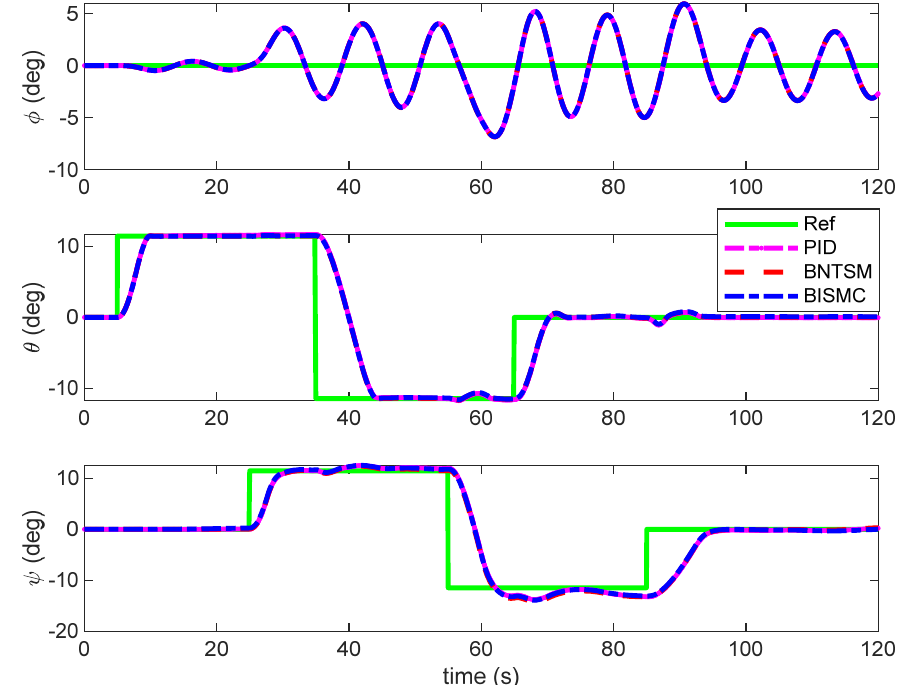
Figure 8. Attitude responses with fault compensation.